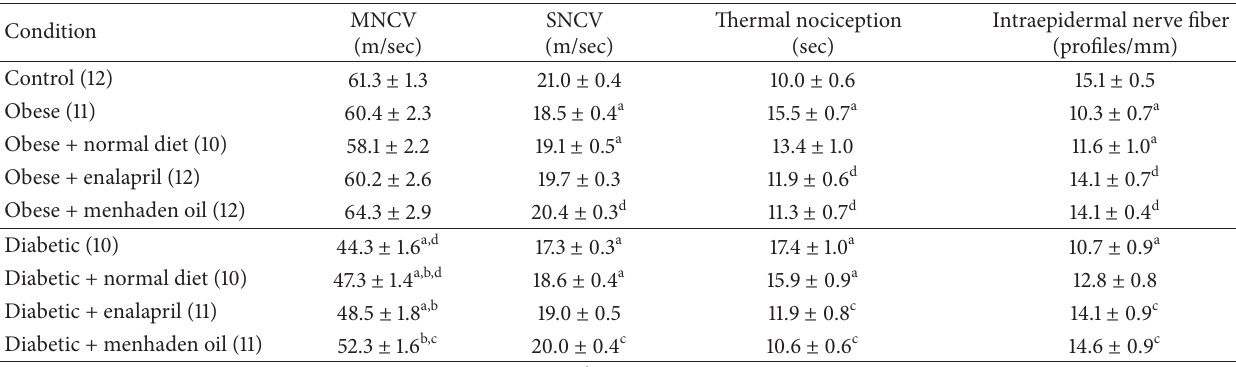
Table 3: Effect of reversal of high fat diet, enalapril, or menhaden oil in diet-induced obese or type 2 diabetic rats on motor and sensory nerve conduction velocity, thermal nociception, and intraepidermal nerve fiber density.